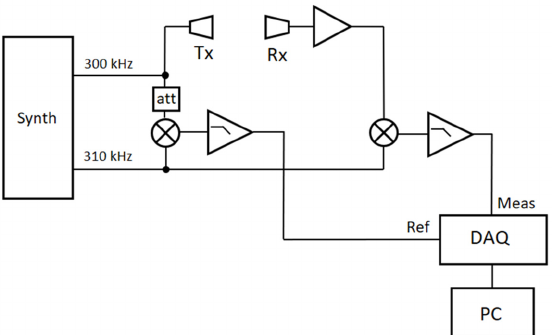
Figure 2. Simplified schematic of the electronics. See text for a detailed description of the components. A dual channel synthesizer generates two signals at 300 and 310 kHz, respectively.